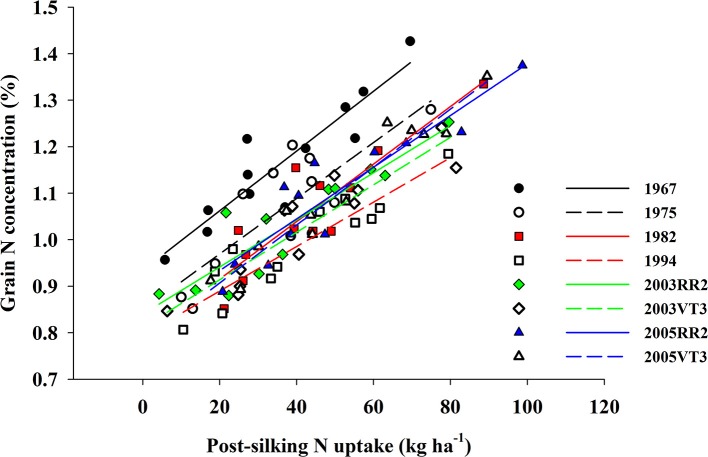
The correlation between grain N concentration (%) and post-silking N uptake (kg ha−1) for all eight hybrids when averaged across all treatments and locations. 1967: GNC = 0.9 + 0.006 × PostN, R2 = 0.84, p < 0.001; 1975: GNC = 0.8 + 0.006 × PostN, R2 = 0.67, p = 0.001; 1982: GNC = 0.8 + 0.006 × PostN, R2 = 0.81, p < 0.001; 1994: GNC = 0.8 + 0.005 × PostN, R2 = 0.85, p < 0.001; 2003RR2: GNC = 0.8 + 0.005 × PostN, R2 = 0.83, p < 0.001; 2003VT3: GNC = 0.8 + 0.005 × PostN, R2 = 0.84, p < 0.001; 2005RR2: GNC = 0.8 + 0.006 × PostN, R2 = 0.85, p < 0.001; 2005VT3: GNC = 0.8 + 0.006 × PostN, R2 = 0.93, p < 0.001.